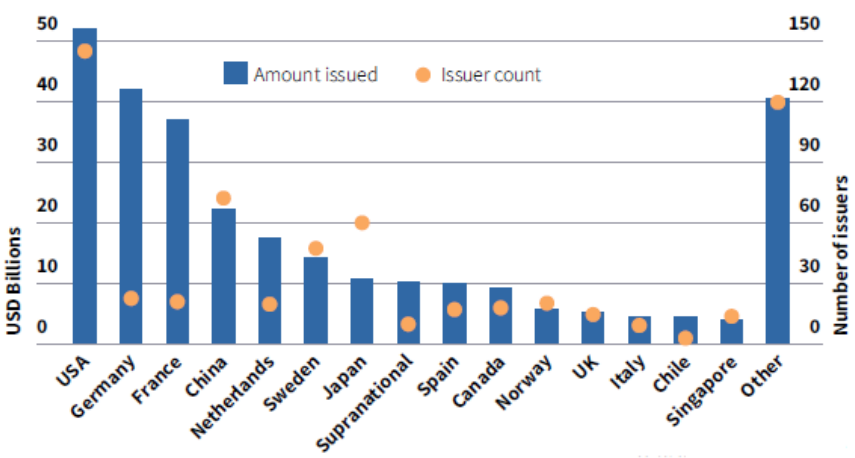
Figure 2. Amount of green bond issued by country (2020). Source: Harrison and Muething (2021); p. 7.